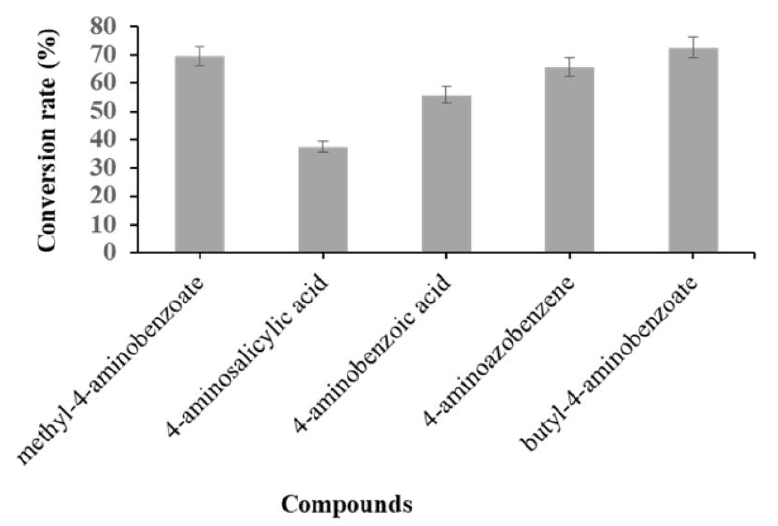
Figure 3. Bioconversion of para-positioned amine functional group compounds after 10 h of incubation.